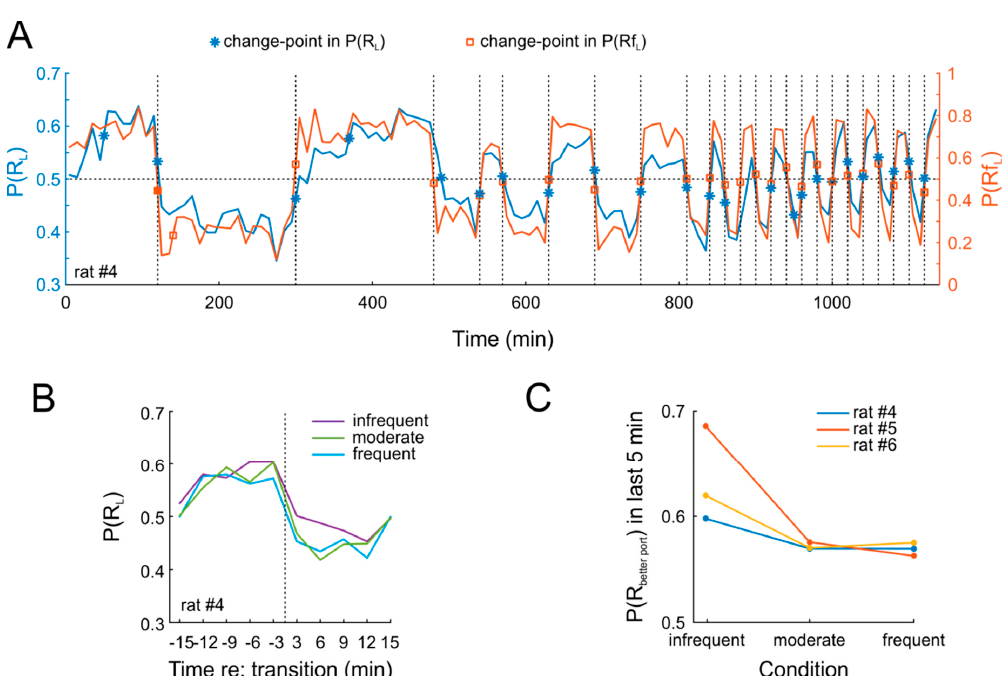
Figure 4. Rats quickly adapt when reinforcement contingencies change multiple times per session. ( A ) Dynamic response allocation resulting from changes in P(Rf L ) across all 15 experimental sessions in 10-min bins for an example animal. Blue and red symbols denote change-points for responses (asterisks) and reinforcements (squares). Thin horizontal dotted line denotes unbiased responding; vertical dotted lines denote changes in P(Rf L ). ( B ) Relative choice proportion before and after changes in reinforcement contingency (vertical dotted line) for infrequent (purple), moderately frequent (green), and frequent (cyan) changes. The data from the other rats tested with different sequences were